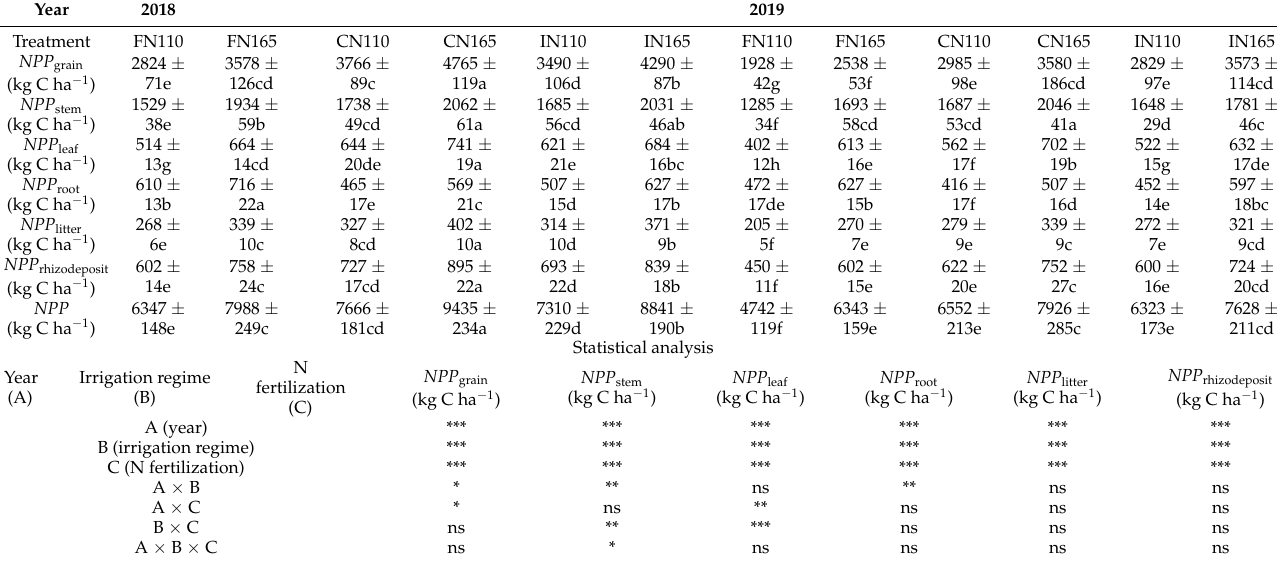
Table 2. Changes in NPP components in paddy fields after the implementation of water-saving irrigation